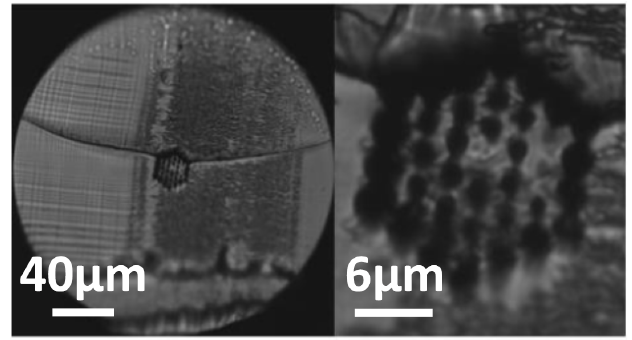
Figure 8. mPOF fiber end unsatisfactory surface roughness due to bad blade condition.